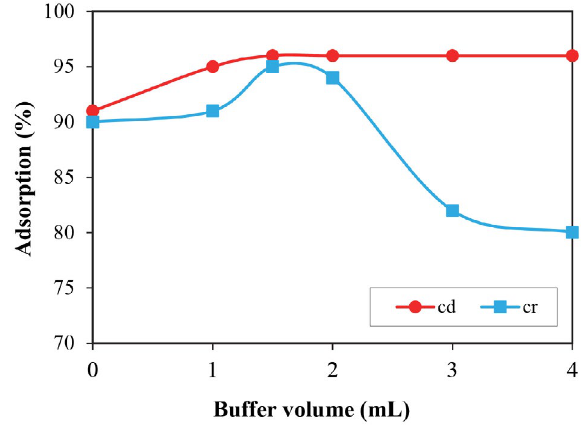
Fig. 3: Effect of pH on chromium (III) and cadmium (II) ion ad- sorption using CFNC